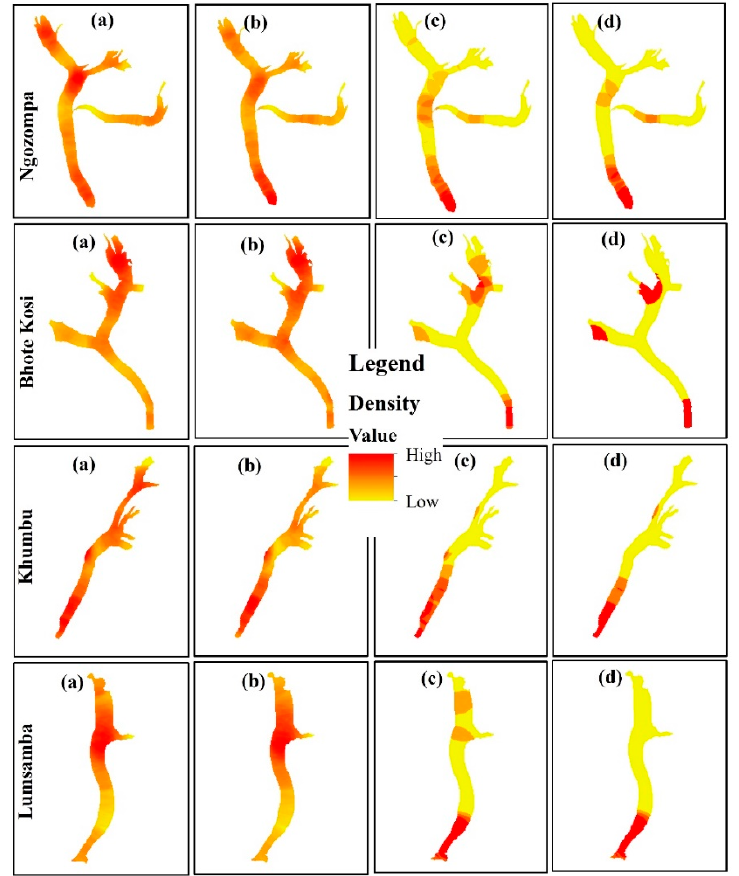
Figure 10. The densities of supraglacial ponds at the surface of the four selected glaciers with different area thresholds of the ponds, being greater than ( a ) 20 m 2 , ( b ) 100 m 2 , ( c ) 3600 m 2 , and ( d ) 5000 m 2 .